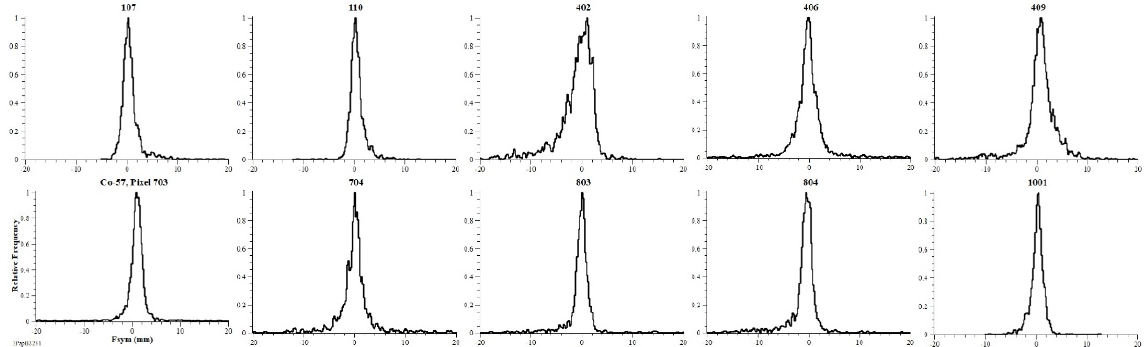
Figure 12. Fsym spectra from Co-57 data regarding the selected decuple of pixels of the crystal-array with the best charge- symmetry response. Spectra are shown, from top-left to bottom-right, in ascending RRCC crystal-pixel order. Common axes titles and plot descriptions are reported only once in the bottom-left frame for better clarity. The selection criterion,